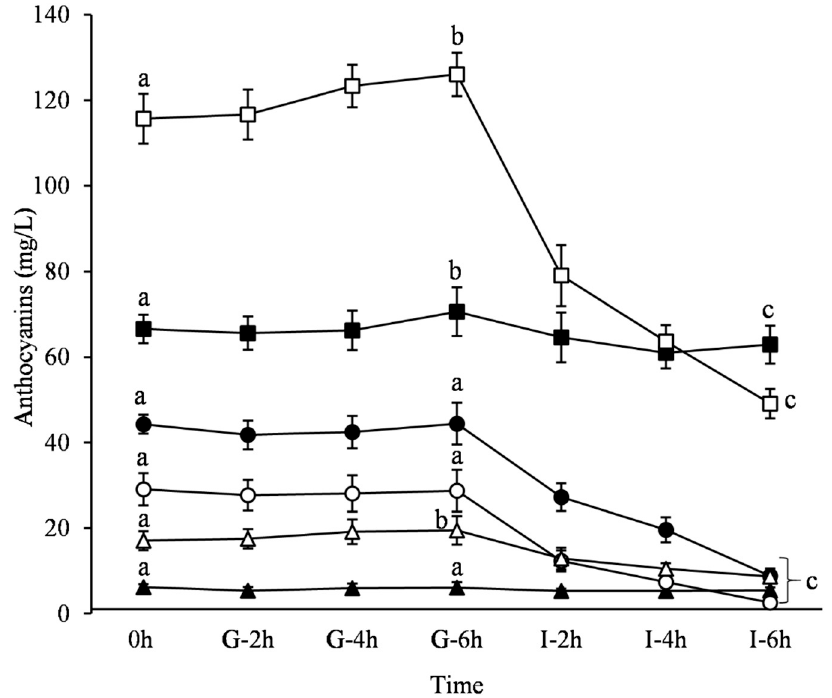
Figure 4. Evolution of each individual ACN of PJ during the simulated digestion process (SDP) (0 h; G-2 h, G-4 h, G-6 h: samples under the gastric condition; I-2 h, I-4 h, I-6 h: samples under the intestinal condition; - ● -: Dp-3,5-diglucoside; - ○ -: Dp-3-glucoside ; - ■ -: Cy-3,5-diglucoside; - □ -: Cy-3-glucoside; - ▲ -: Pg-3,5diglucoside; - ∆ -: Pg-3-glucoside). Different letters denote statistical significance ( p < 0.05) between time points of each ACN.